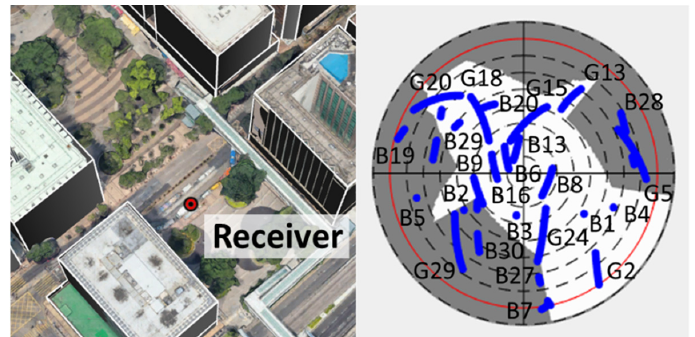
Figure 8. The location and the corresponding sky-plot with building boundaries for the one-hour static experiment on an intersection in an urban area. The right sky-plot demonstrates the satellite distribution and the building blockage (shaded area) on the experiment location (red marker).